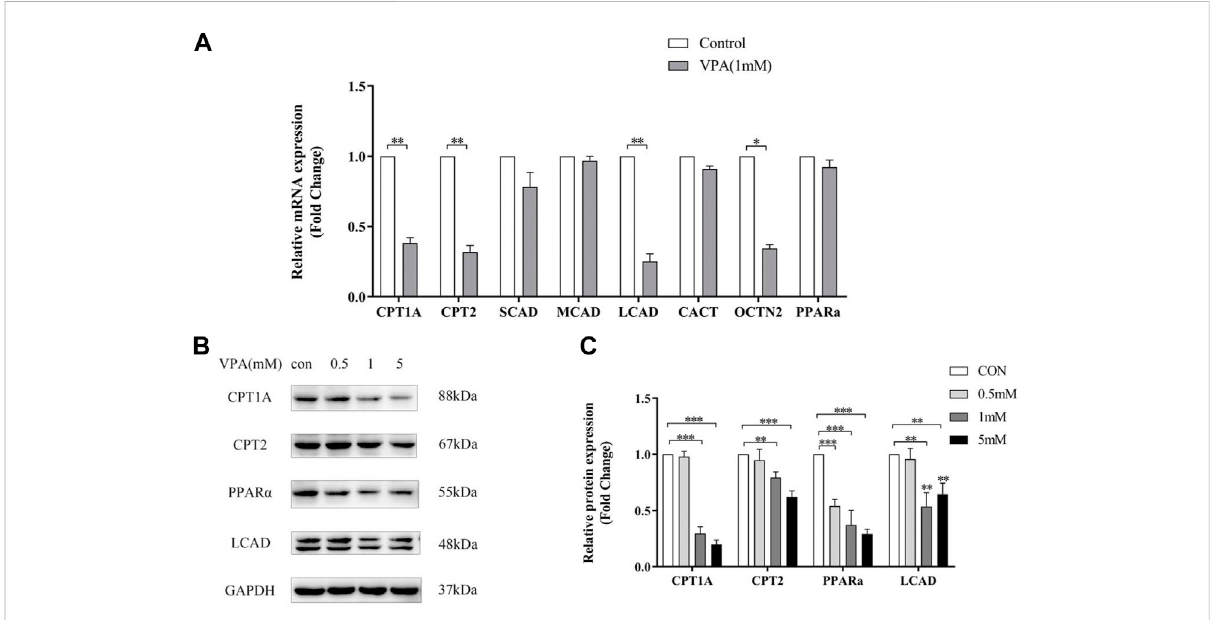
FIGURE 7 Effect of VPA on ACs-related gene expression in LO2 cell. (A) Real-time PCR analysis of VPA (1 mM) on ACs-related metabolism genes. (B – C) Western blot analysis of the effect of VPA on protein expression of ACs -related genes. Data are expressed as the mean ± SD ( n = 3). *p < 0.05, **p < 0.01, ***p <